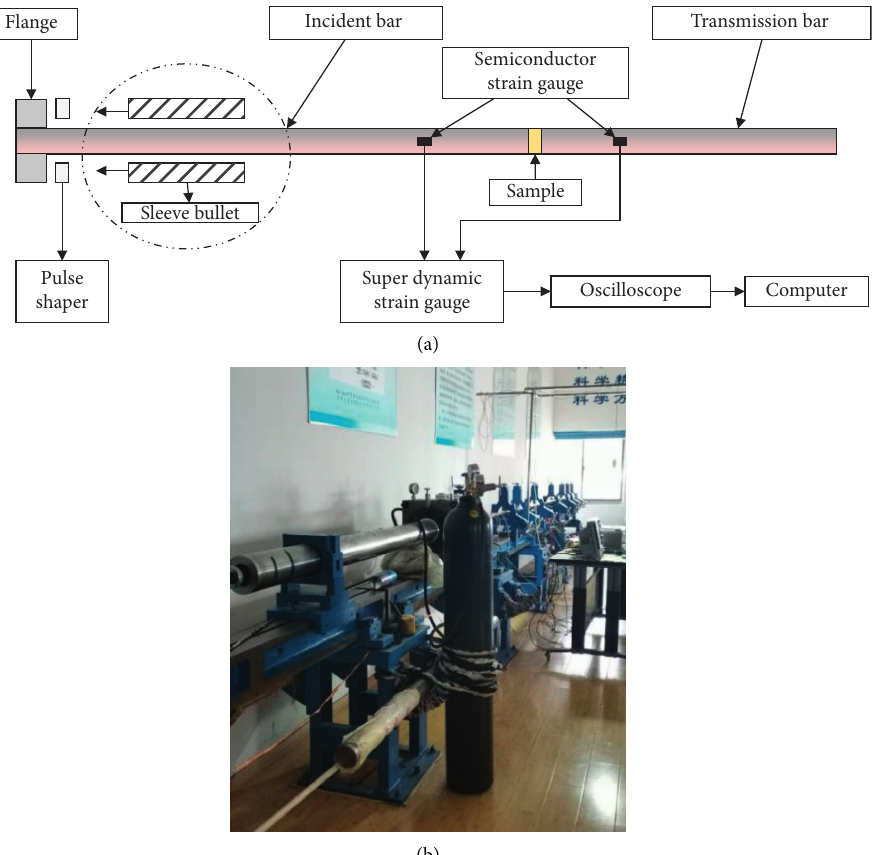
Figure 3: Principle and material object of the SHTB